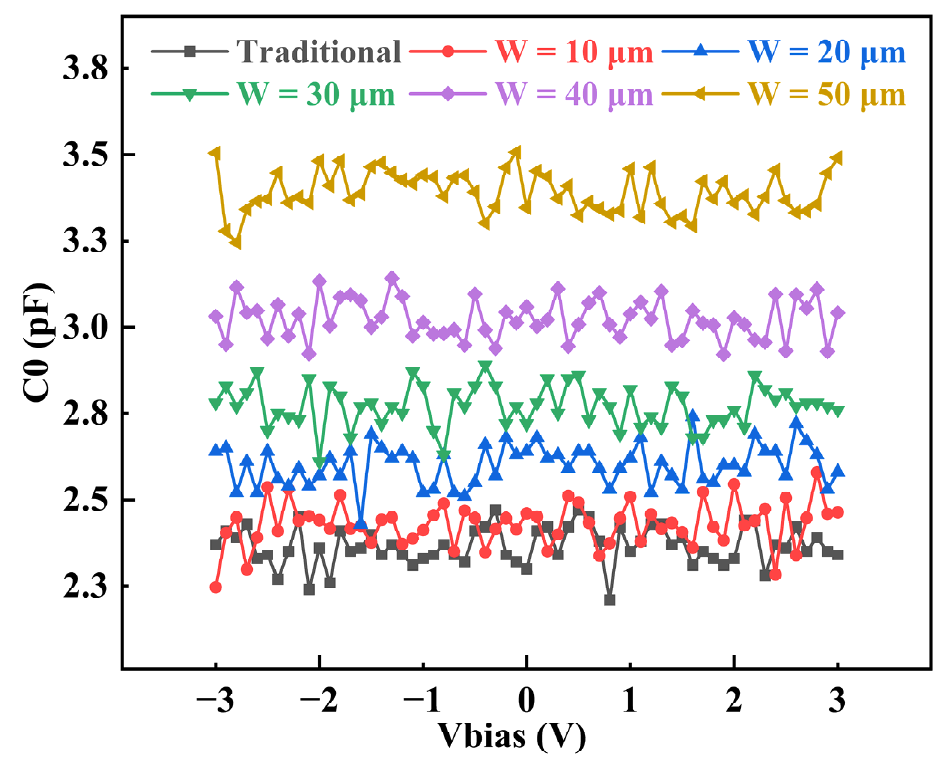
Figure 8. The measured C-V curves of the FBARs with support columns of different widths.